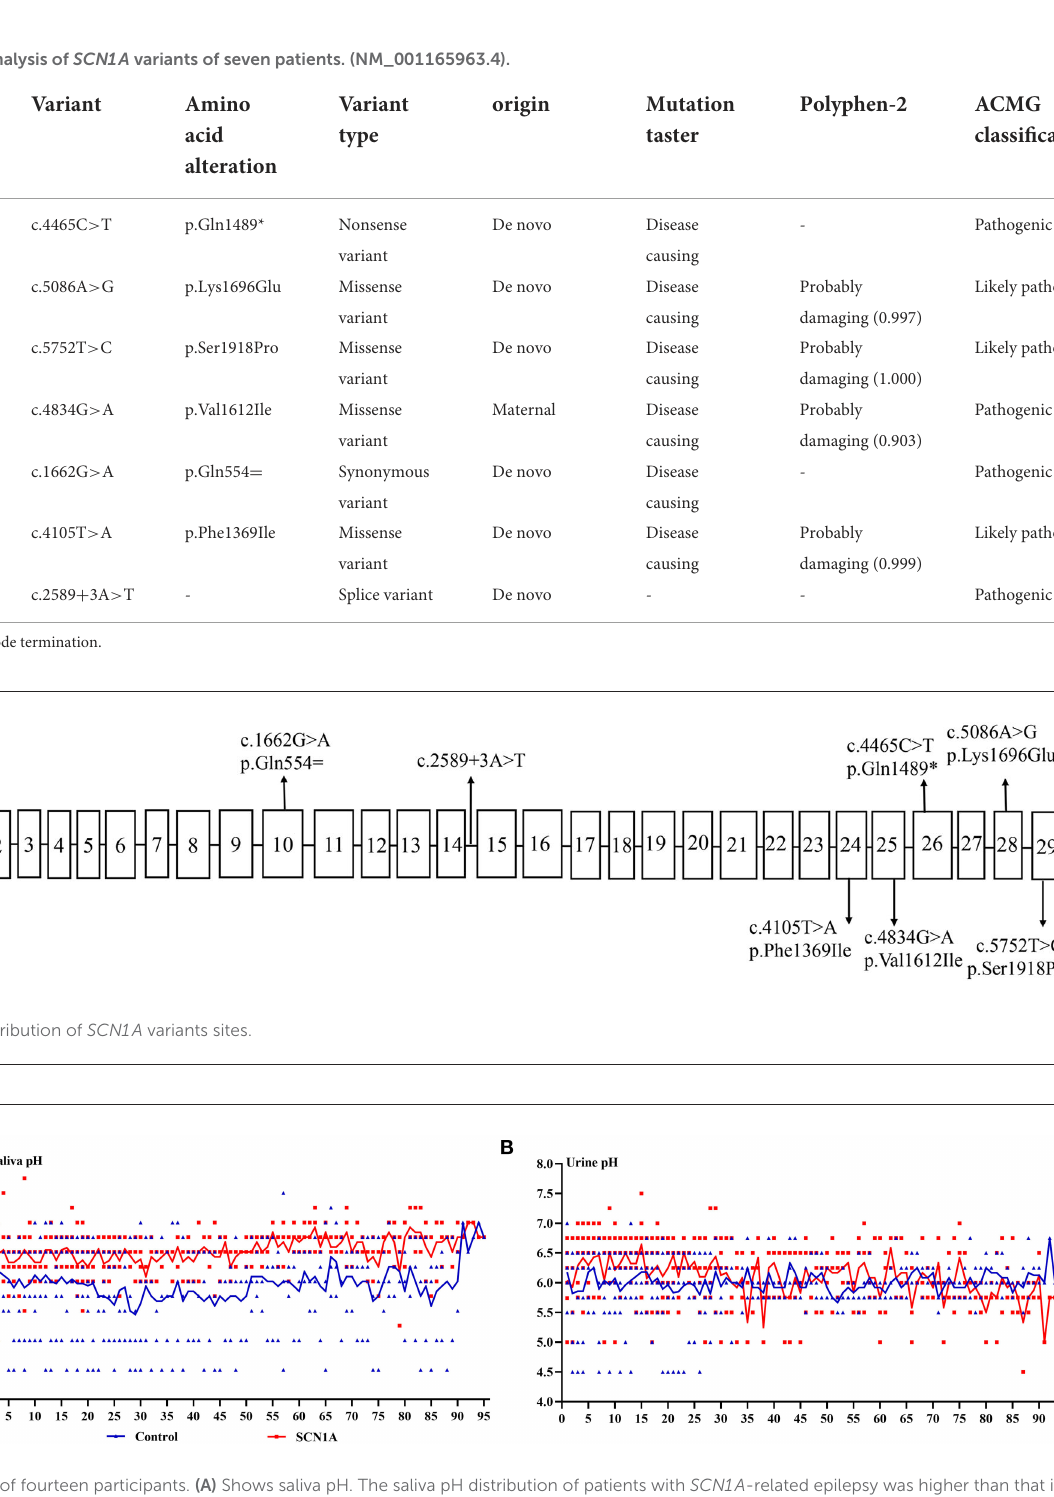
pH. Disrupting mouse ASIC1a increased the severity of seizures and CO 2 inhalation did not terminate seizures, while overexpressing ASIC1a had the opposite effect